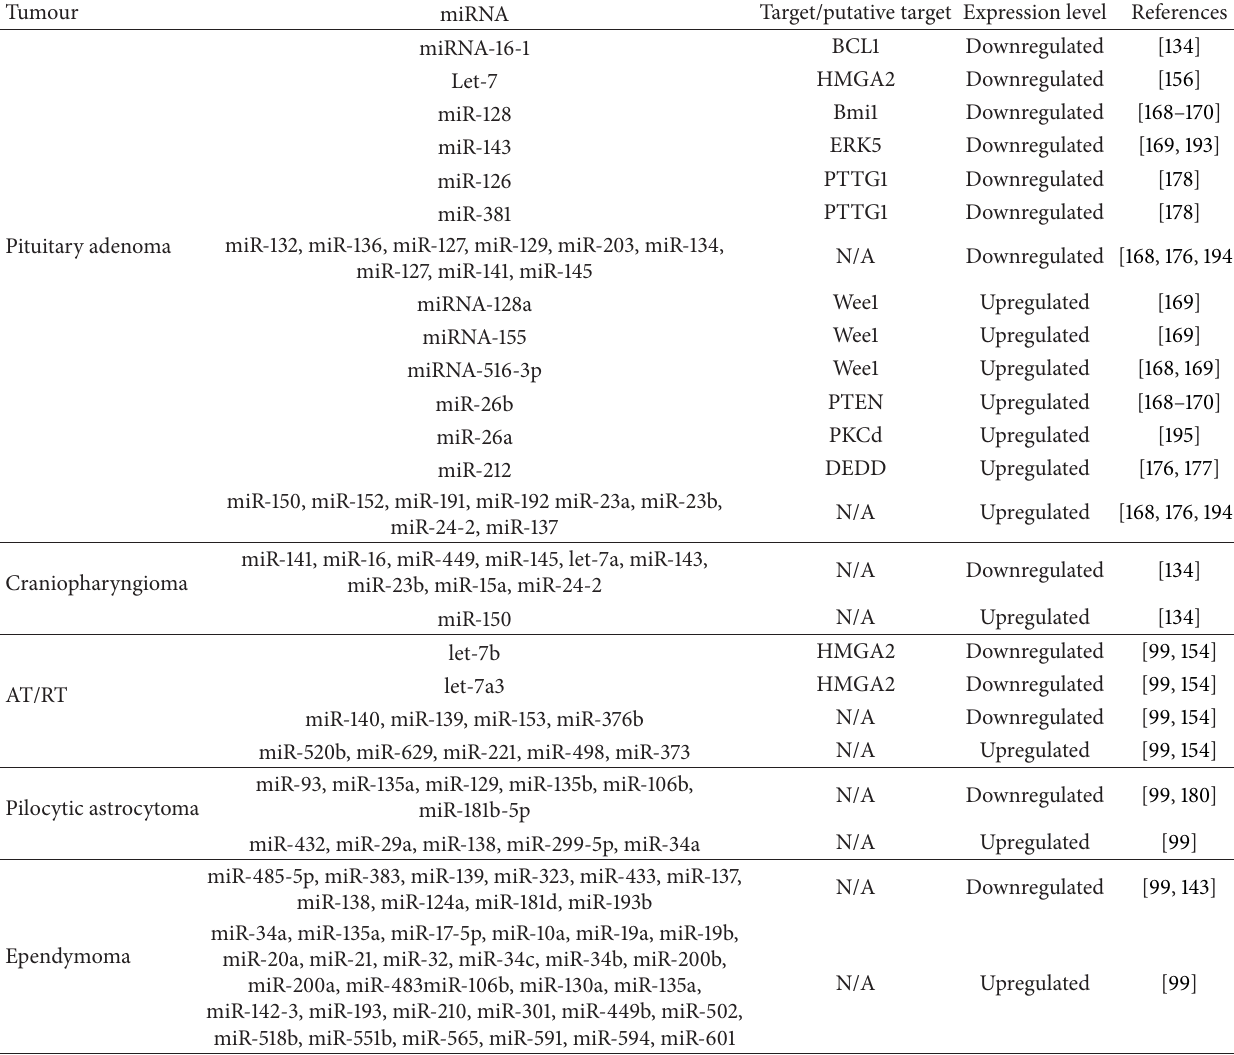
Table 3: miRNAs regulating BTICs in other CNS